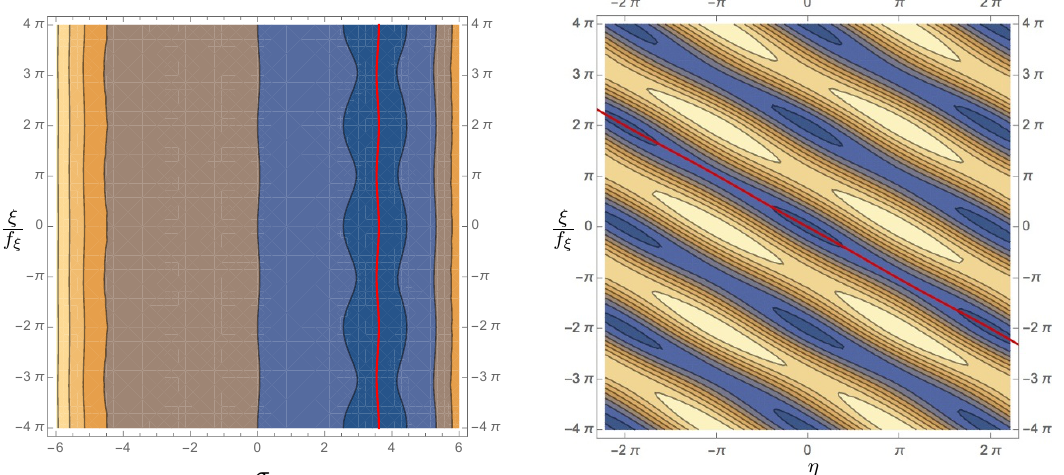
Figure 8 . Countour plots of the back-reacted scalar potential as a function of ( (cid:27); (cid:24) ) (left) and ( (cid:17); (cid:24) ) (right). The valleys of the scalar potential are represented by the dark-blue regions, while the brown and orange regions correspond to steeper faces of the scalar potential. The red curve indicates the (cid:13)at direction along which a potential in(cid:13)ationary trajectory can partly run. The back-reacted scalar potential is plotted for the parameter choice (cid:22) = 10 (cid:21) = (cid:20) = 10 M = 10 16 GeV.